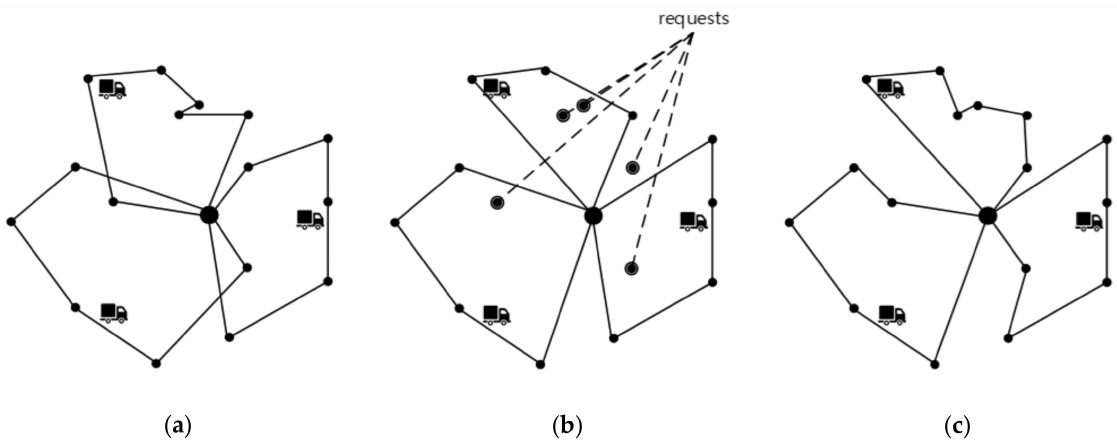
Figure 10. An Illustration of Large Neighborhood Search Algorithm. ( a ) Before removal. ( b ) After removal (destroy). ( c ) After repair.